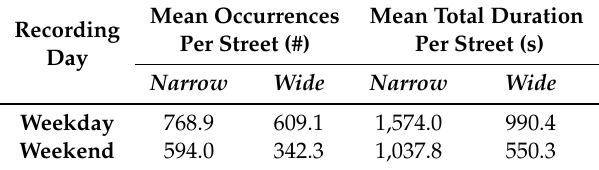
Table 4. Mean number of occurrences and total duration per street obtained for weekday and weekend day, distinguishing between narrow and wide streets (see Table 1), being the diurnal period defined as 06:00–22:00 [29].